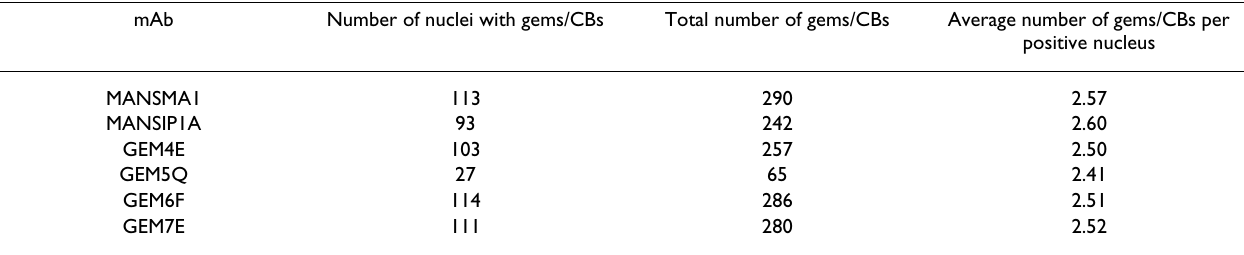
Table 2: Gemin5 staining is "all or nothing".